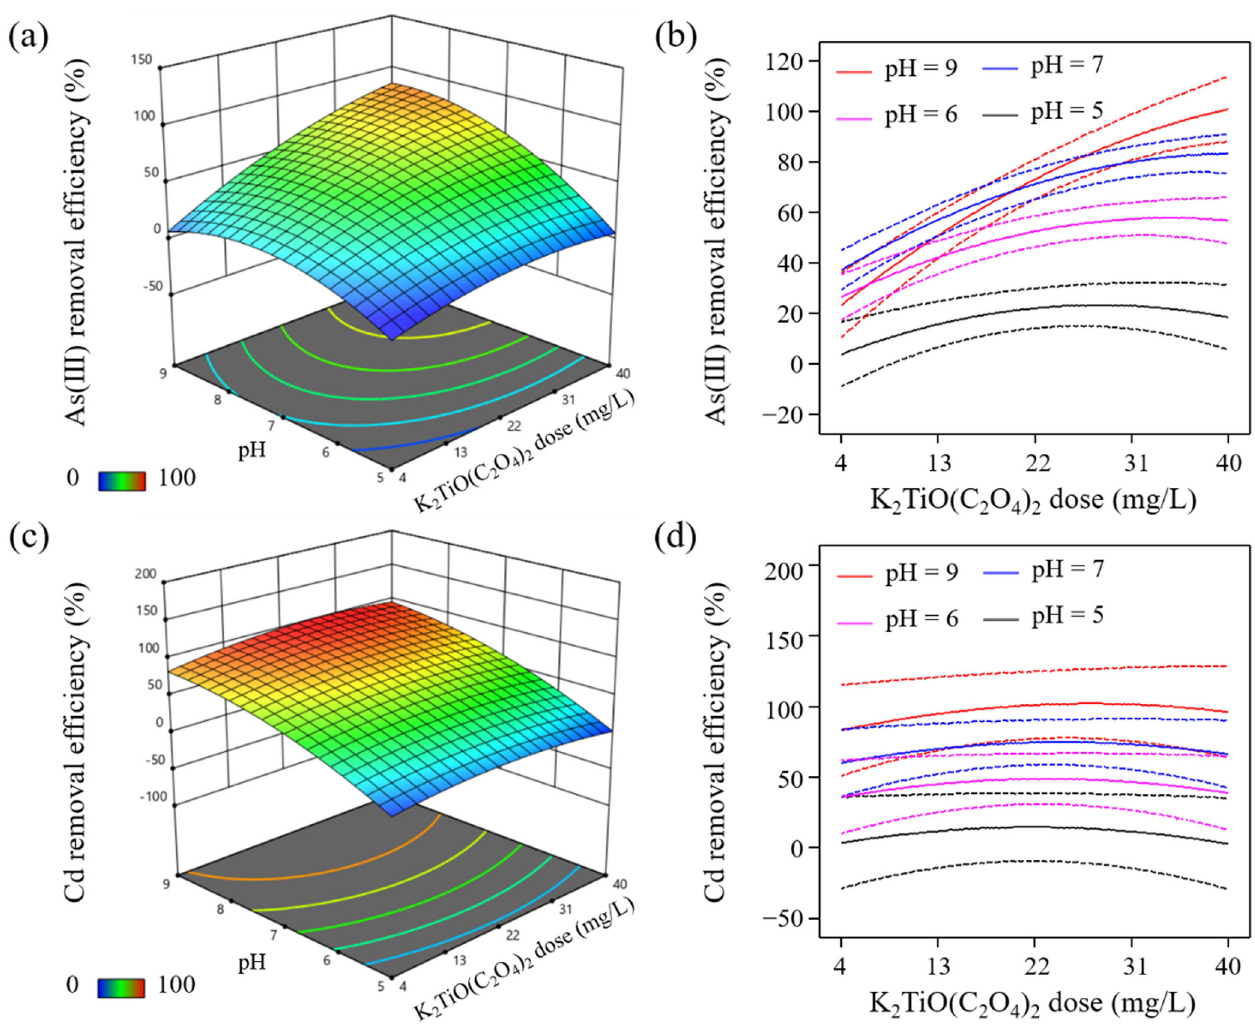
Fig. 2 Response surface and interaction of pH and K 2 TiO(C 2 O 4 ) 2 dose on As(III) and Cd removal ef fi ciencies. ( a ) Response surface of As(III) removal ef fi ciency, ( b ) interaction on As(III) removal ef fi ciency, ( c ) response surface of Cd removal ef fi ciency, and ( d ) interaction on Cd removal ef fi ciency. Other conditions were initial As(III) concentration of 500 μ g/L, Cd concentration of 500 μ g/L, and CaCl 2 dose of 30 mg/L. The dash lines in ( b ) and ( d ) are 95% con fi dence interval (CI) CaCl 2 dose of 30 mg/L, and pH of 7 are shown in Supplementary Figure 3. The initial As(III) concentration had no signi fi cant effect on Cd removal and vice versa, indicating no competitive adsorption between As(III) and Cd because of the distinct charges between anions and cations. Moreover, the initial As(III) concen- tration negatively affected the As(III) removal ef fi ciency due to limited binding sites available at constant K 2 TiO(C 2 O 4 ) 2 dose. However, initial Cd concentration showed little in fl uence on Cd removal ef fi ciency. Theoretically, different from As(III), Cd was mainly removed via occlusion. In the occlusion coprecipitation process, the absolute removal amount is usually positively correlated with the initial concentration, but the removal ef fi ciency has little connection with it. According to the hypothesis, the CaCl 2 dose would have a positive effect on Cd removal; however, for both pollutants, CaCl 2 dose showed no signi fi cant in fl uence on the removal ef fi ciency, as presented in Fig. 3, which is consistent with the results shown in Table 1. The P values of the CaCl 2 dose (X 4 ) (for A(III), p = 0.7413; for Cd, p = 0.7461) were much larger than 0.05. A possible reason is that the number of calcium ions (Ca 2 + ) in tap water was